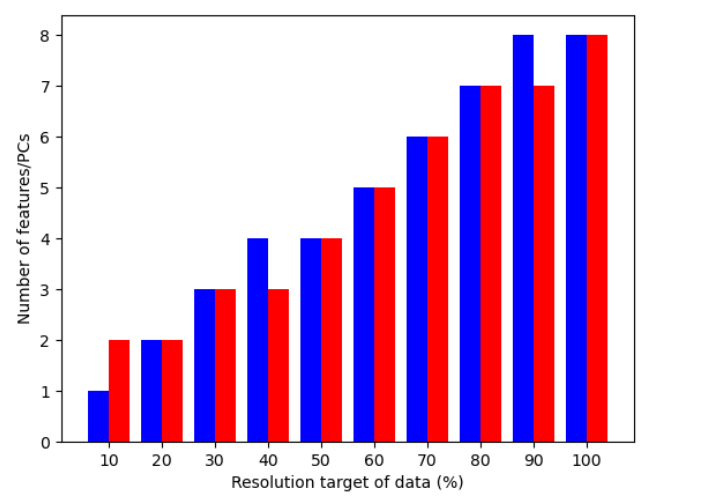
Figure 13. Number of features/PCs according to the target resolution of data.